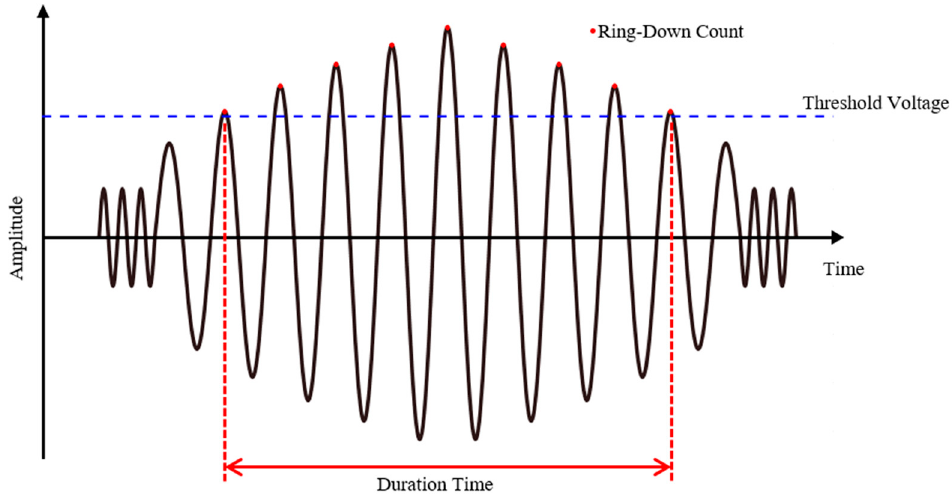
Figure 1. AE parameter.